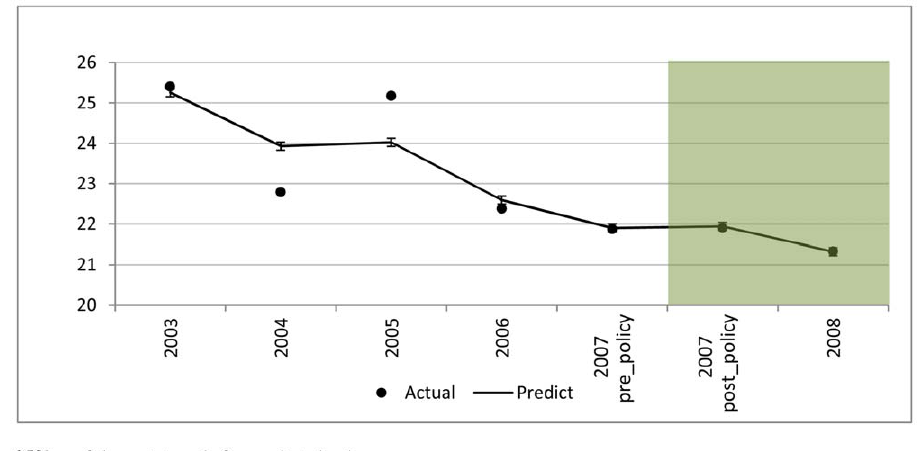
Figure 1. Smoking Prevalence (2003–2008 Mean; 95% CI).